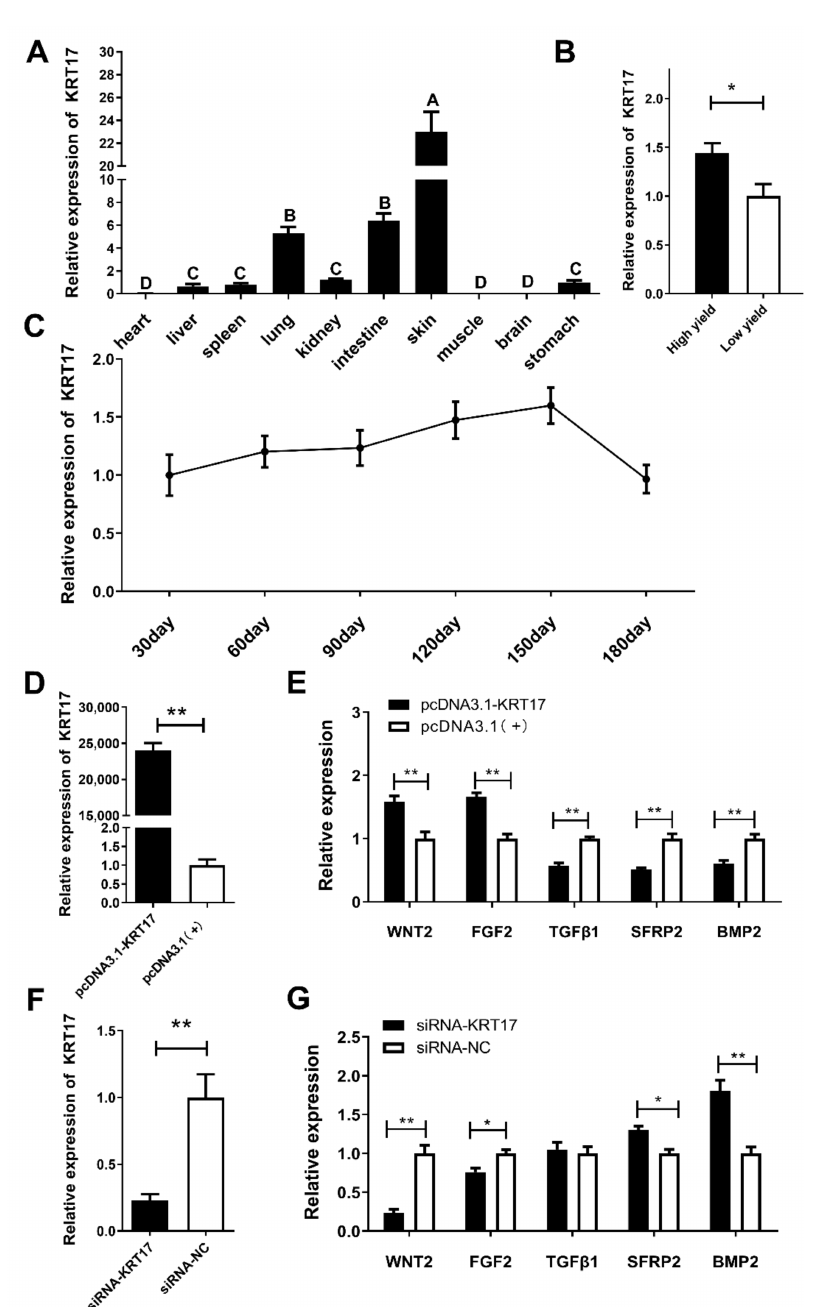
Figure 5. Preliminary analysis of expression and function of KRT17. The expression level of KRT17 in ( A ) different tissues, ( B ) in high and low yield Angora rabbits, and ( C ) in the skin during different hair follicle development cycles; the expression level of KRT17 after ( D ) overexpression and ( F ) RNAi. Expression levels of genes related to hair follicle development after KRT17 ( E ) overexpression and ( G ) RNAi. ** p < 0.01. * p < 0.05. Different letters indicate significant